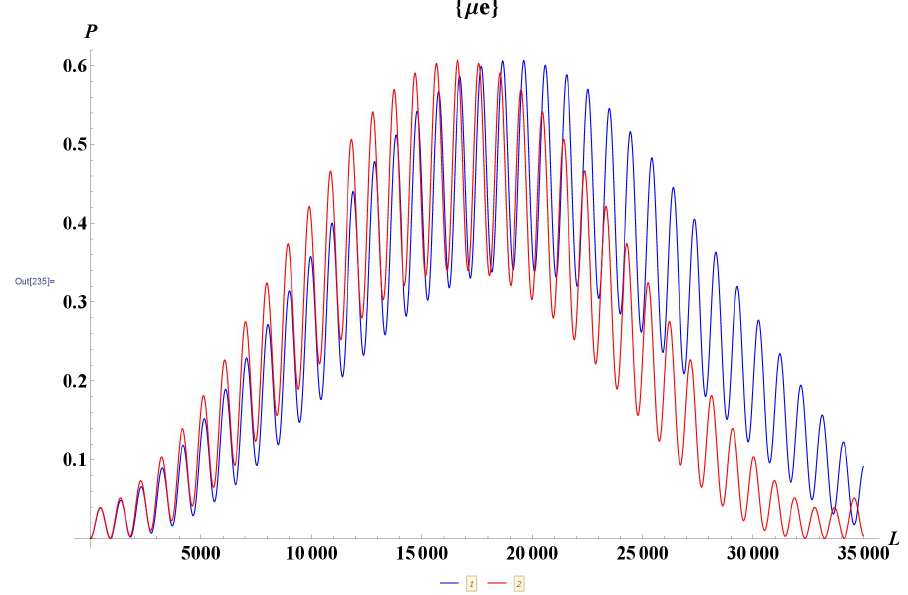
Figure 1. Oscillation probability ν µ → ν e , computed for neutrino energy E = 1GeV, “standard theory” (red curve) and LIV (blue curve), for LIV parameters δ f 32 = δ f 21 = 1 × 10 − 23 , as function of the baseline L . Baseline L in km [73].